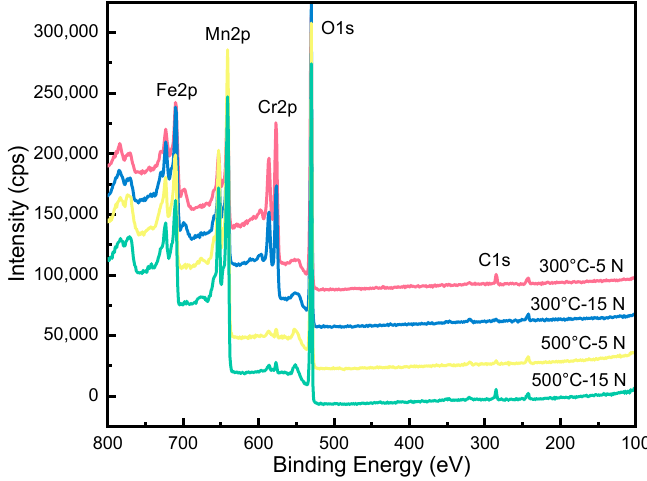
Figure 6. XPS spectra of oxide layers at wear tracks for the HNSS under different conditions.